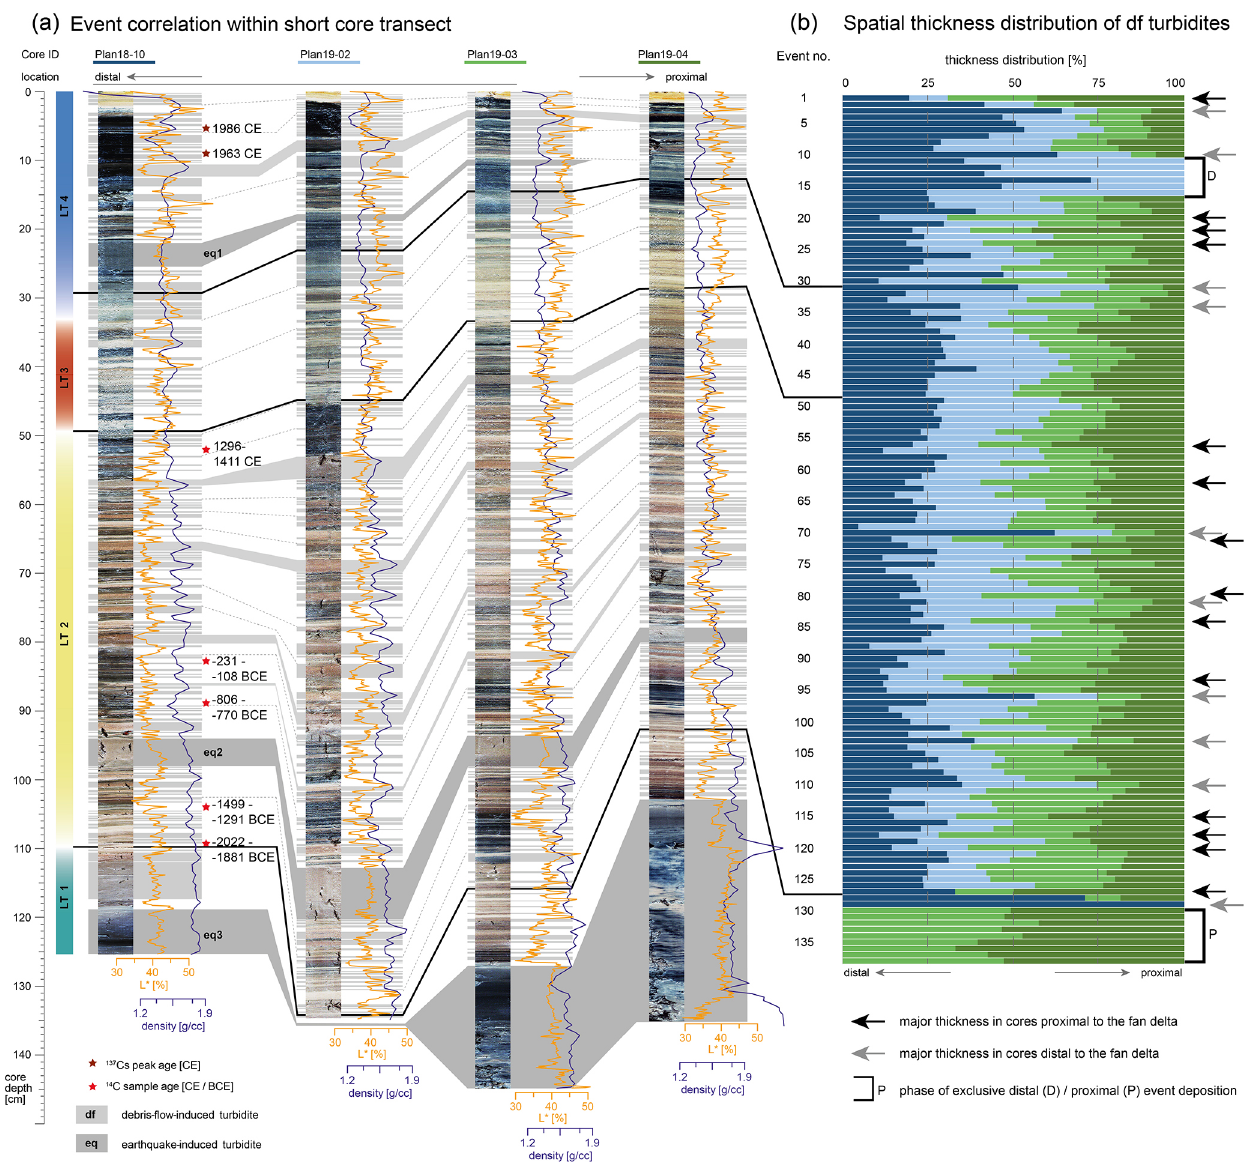
Figure 7. Core-to-core correlation of distal (left) to proximal (right) short cores with respect to the juvenile fan delta. In total, four lithostrati- graphic types can be distinguished based on the initial core images, bulk density (violet), and lightness (orange) and are dated by combined radiocarbon (red stars) and short-lived radionuclide ( 210 Pb and 137 Cs; dark red stars) dating (Fig. S2). Each of the 138 identified debris- flow-induced (df) and 3 earthquake-induced (eq) turbidites are cross-correlated in the four cores and measured for their thickness. (b) The thickness distributions of each df turbidite in the four short cores (individual thickness relative to accumulated thickness in the four cores) are colour-coded based on the corresponding core and show different deposition patterns for different events and